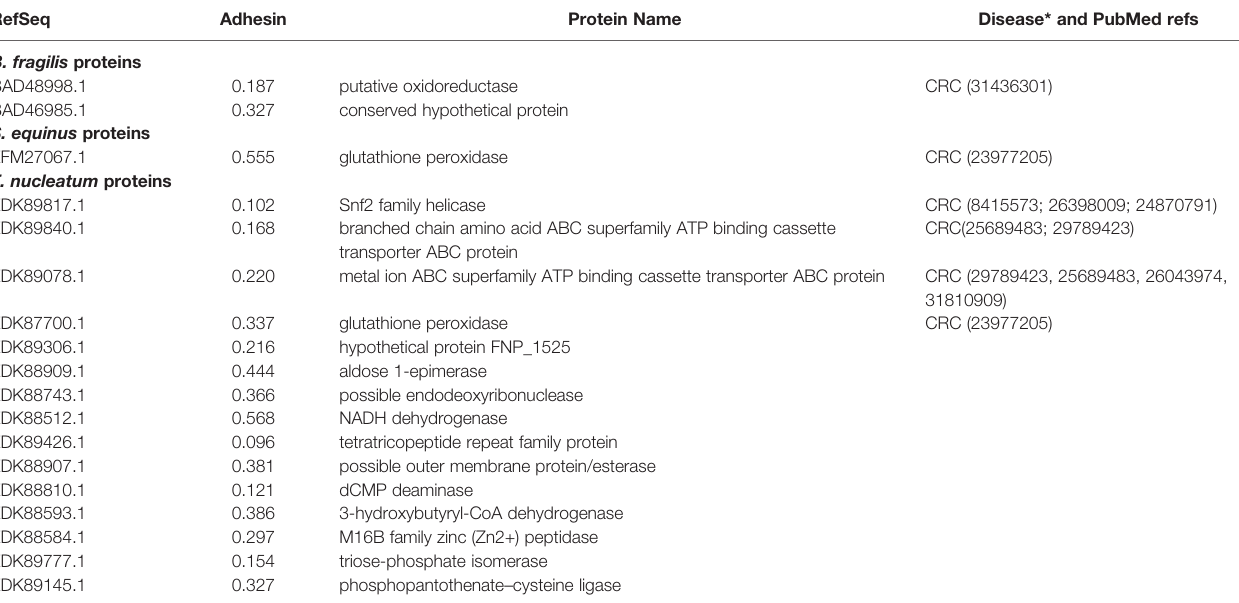
TABLE 1 | Vaxign predicted gut microbiome human homology proteins that likely become autoantigens in human diseases.